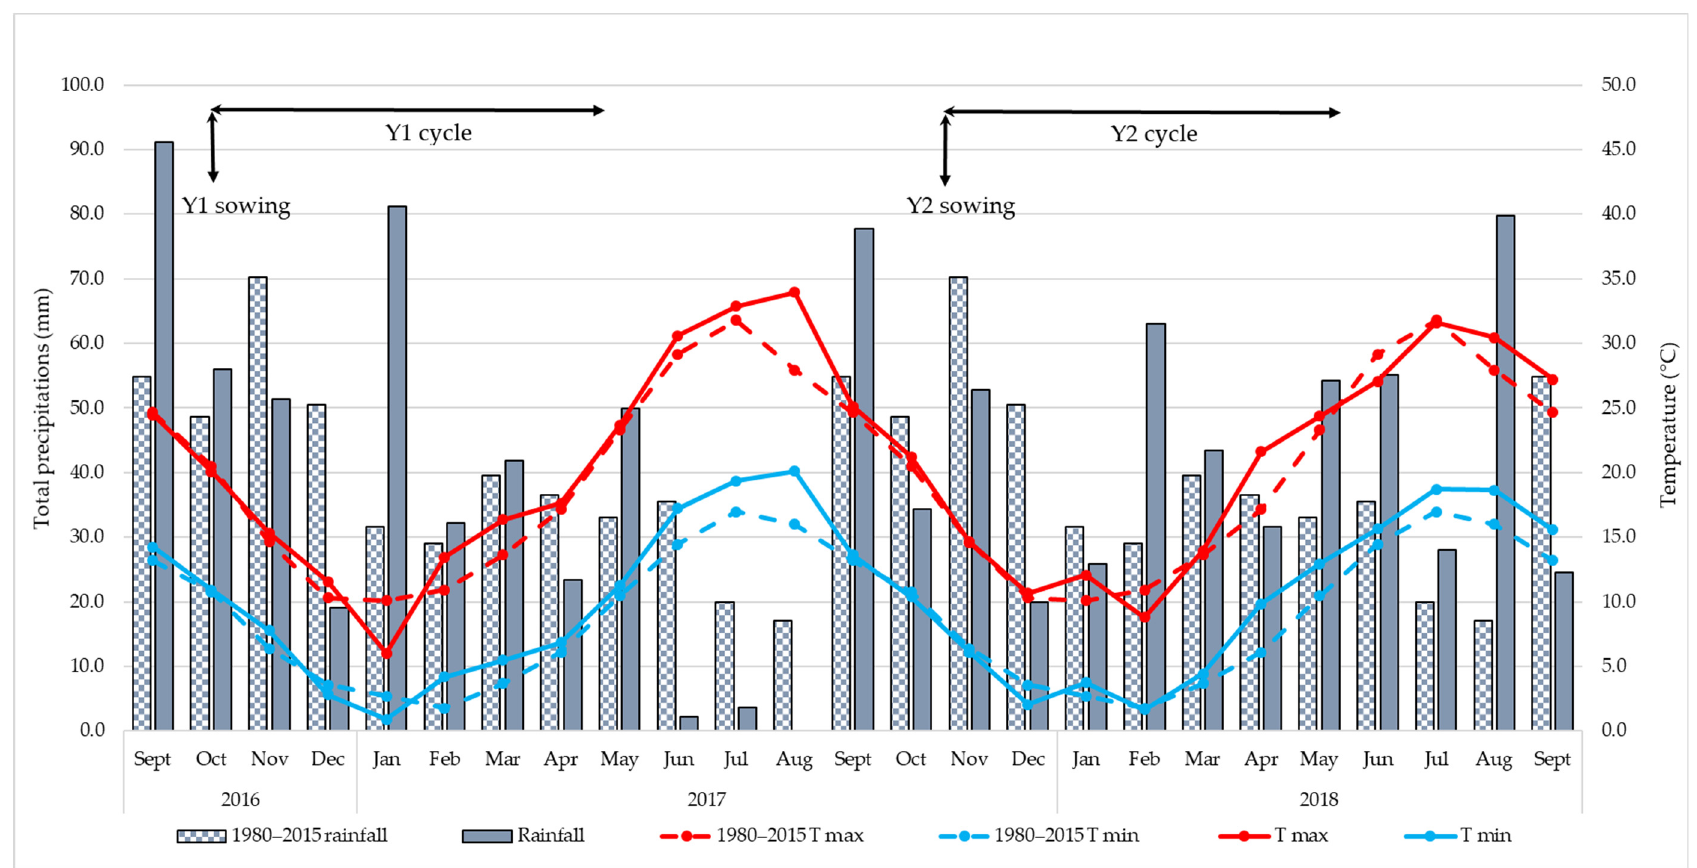
Figure 1. Monthly precipitations and mean minimum and maximum air temperatures (°C) during the two-year study period (Y1: 2016–2017 and Y2: 2017–2018) compared to average long-term (1980–2015) values. Chart legend: Dotted histogram and lines indicate long-term (1980–2015) rainfall (dotted grey) and temperatures (maximum: dotted red; minimum: dotted light blue). Solid coloured histogram and lines indicate rainfall (grey) and temperatures (maximum: red; minimum: light blue) during the study period. Vertical arrows show the sowing dates (Y1: October 2016; Y2: October 2017); horizontal double-headed arrows indicate the length of the crop cycle in the two test years.